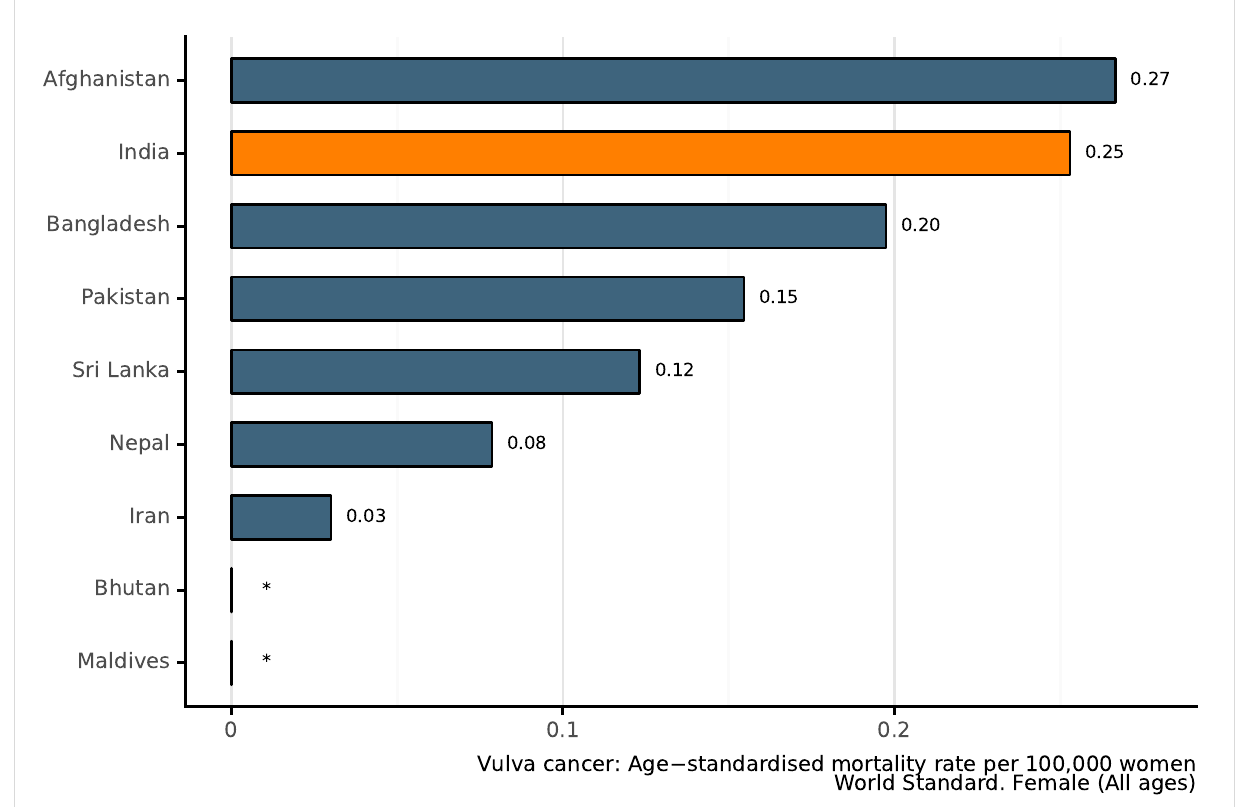
Vulva cancer: Age standardised mortality rate per 100,000 women World Standard. Female